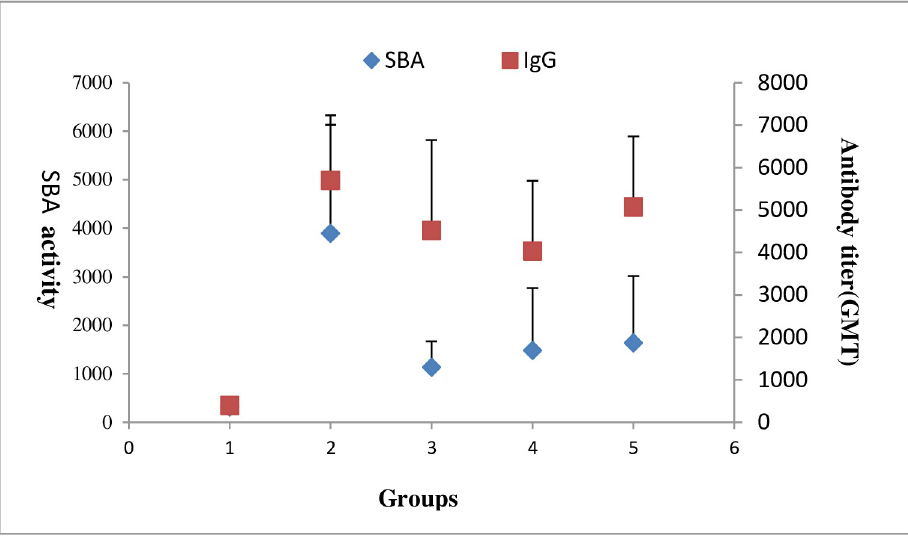
Fig 4. SBA activity and anti-GAMP antibody levels of conjugated and unconjugated GAMP, showing a consistent trend and positive correlation between the two groups ( R = 0.604, P < 0.05). The results of SBA and anti-GAMP total IgG were expressed as the reciprocal of geometric mean titer (GMT). The 1–5 numbers on the horizontal axis represent Group GAMP, GAMP-PspA1, GAMP-PspA2, GAMP-PspA3 and GAMP-TT,